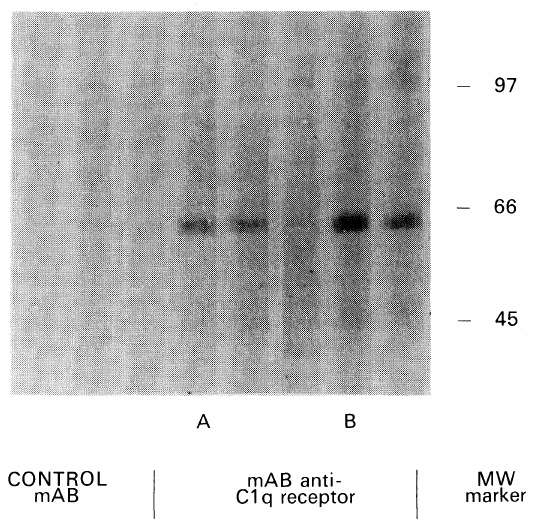
FIG. 4. Western blot analysis of monoclonal antibody against C1 q-R. Five (left lanes) or lO/g lysates of endothelial cell membranes (A) or PMN membranes (B) were separated by electrophoresis, blotted onto nitrocellulose and analysed for reactivity with D5-anti-ClqR.